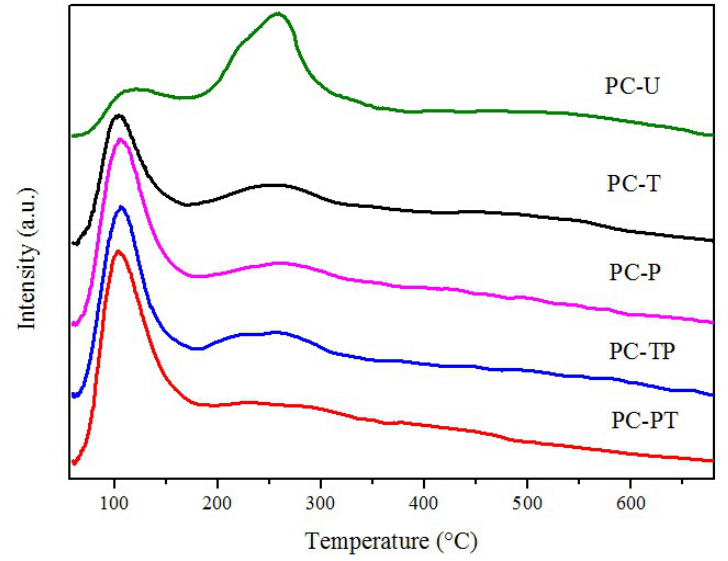
Figure 7. O 2 -TPD profiles of different Pt/CeO 2 samples.